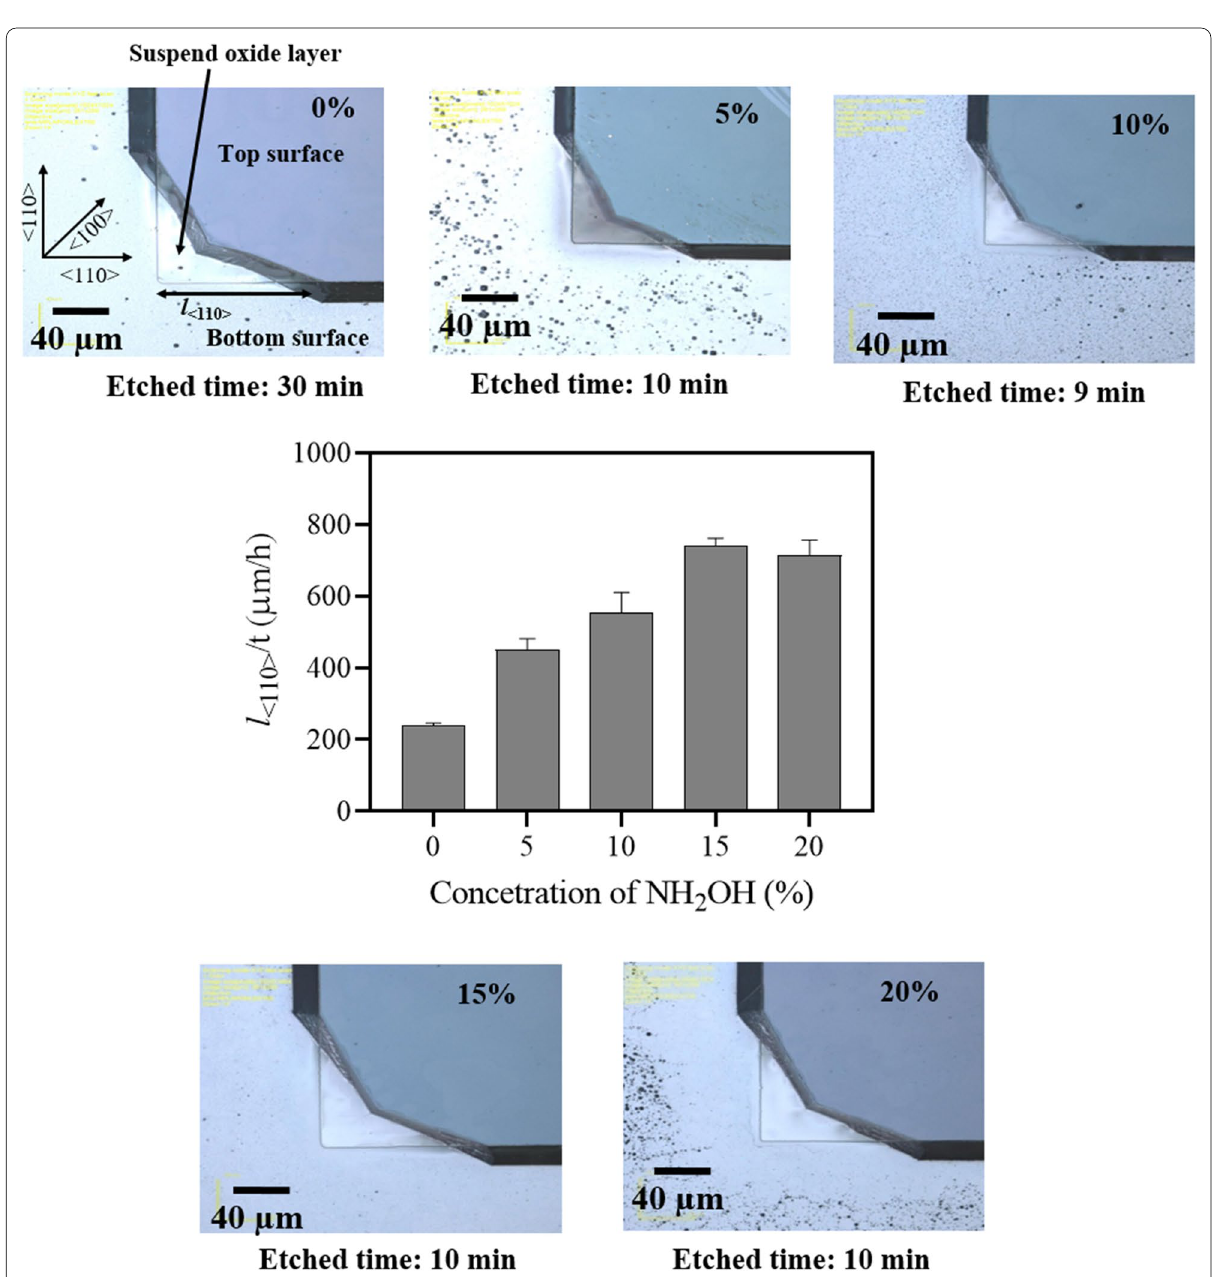
Fig. 54 Etching characteristics at convex corner along < 110 > direction on Si{100} wafer surface in various concentrations of NH 2 OH-added 20 wt% KOH at 75 1 ºC ±